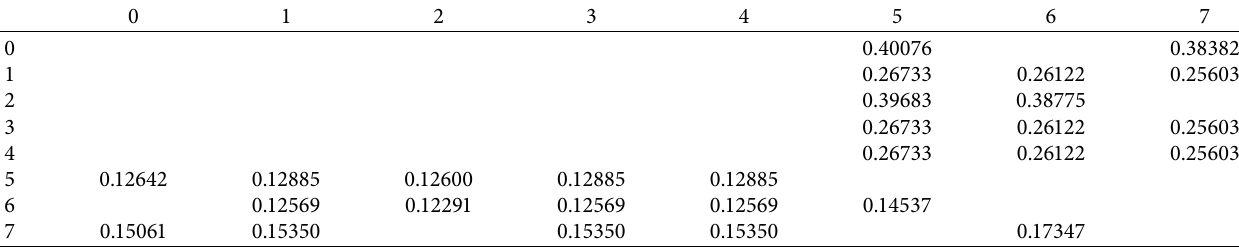
Table 8: Spread probability of each infected node at timeslot 1.